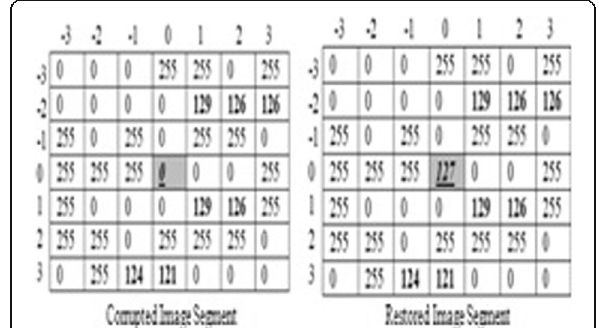
Fig. 6 Illustration of case 3 in case A